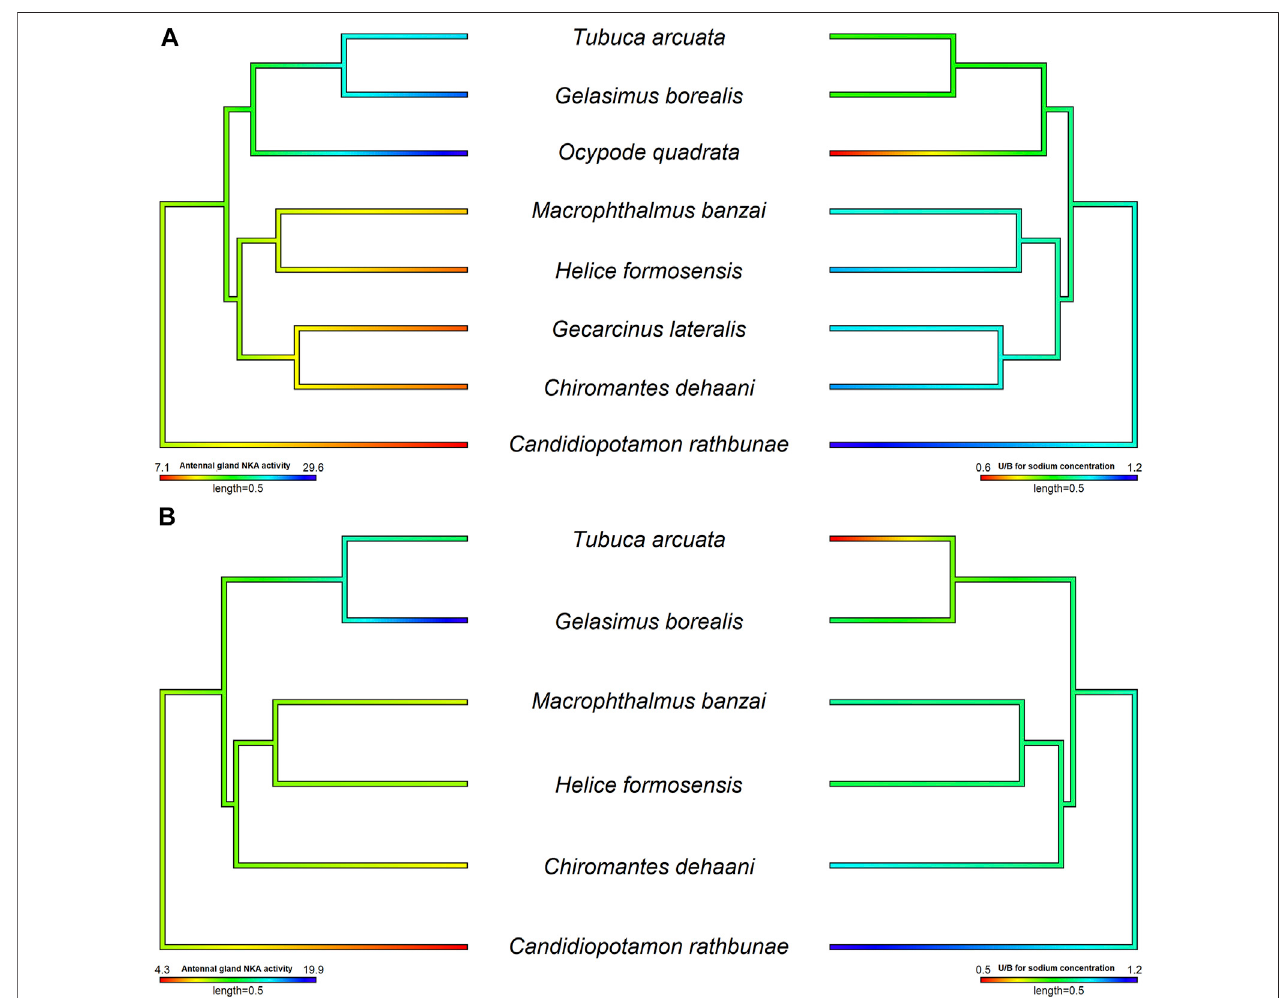
FIGURE3| TherelationshipbetweenantennalglandNKAactivityandU/HforNa + concentration intheantennalglandofdifferentcrabspeciesinhypo-andhyper- osmotic environments. The phylogenetic tree was generated by Bayesian inference with COI, 12S and 16S rDNA. The antennal gland NKA activity and U/H for Na + concentration of crabs in 5 or 35 ppt were mapped on the phylogenetic tree and the ancestor status was predicted by the phylogenetic structure. The correlation betweenantennal gland NKAactivity andU/H forNa + concentration wasanalyzed byPGLS. Leftpicturesweretheresults ofantennalglandNKA activity, and right sides were U/H for Na + concentration. (A) The antennal gland NKA activity was correlated with the U/H for Na + concentration in the antennal gland when species were transferredintohypo-osmoticenvironments( t value= − 5.7963,df=8, p =0.0012,R 2 =0.88). (B) TherewasnocorrelationbetweenantennalglandNKAactivityandthe U/H for Na + concentration inthe antennal gland when species weretransferred into hyper-osmoticmediums ( t value = − 0.1627, df =6, p = 0.8786, R 2 < 0.001). Dataof Ocypode quadrata are from DeVries et al. (1994). Data of Gecarcinus lateralis are from Gross (1964) and DeVries et al. (1994). Data of Candidiopotamon rathbunae are from Wang and Lin